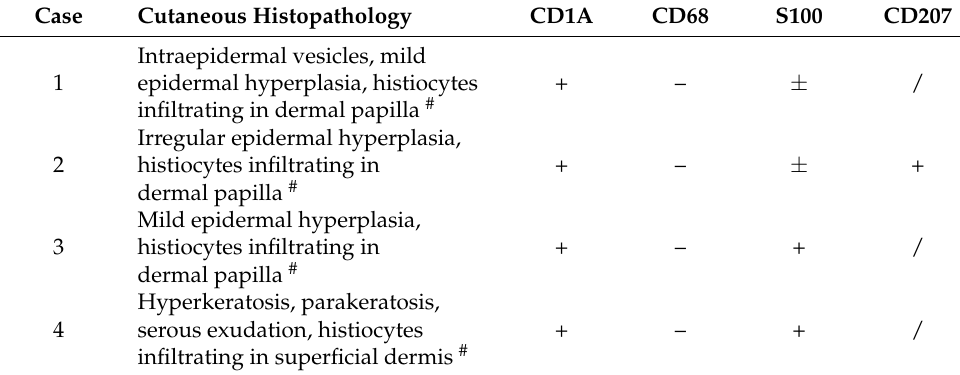
Table 2. The histopathological features of lesions.